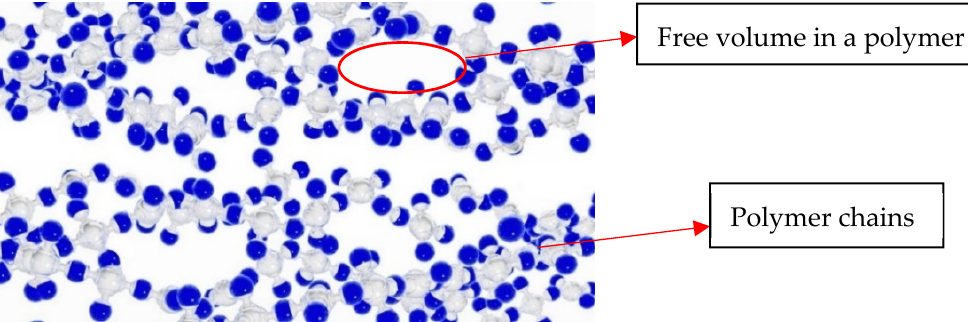
Figure 5. Schematic representation of the free volume in the polymers.